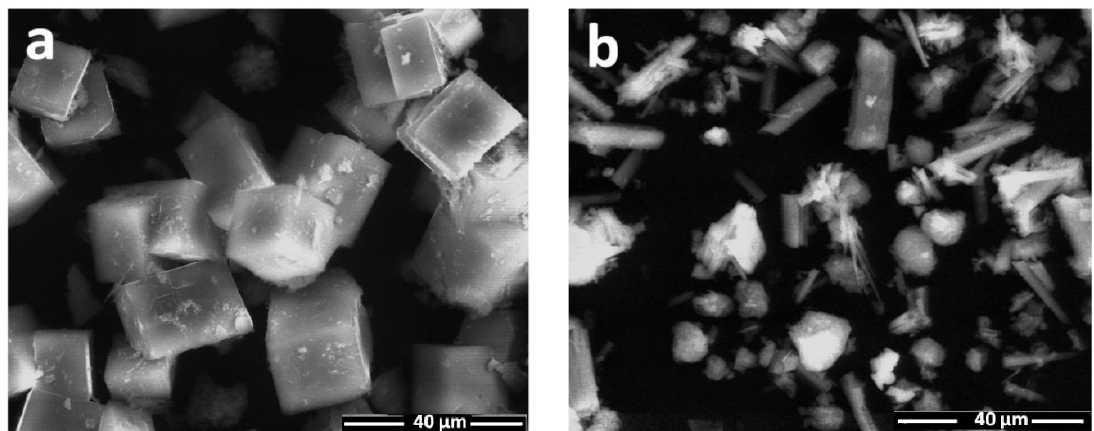
Figure 3. SEM images of ( a ) KCL-102 and ( b ) KCL-102-air.